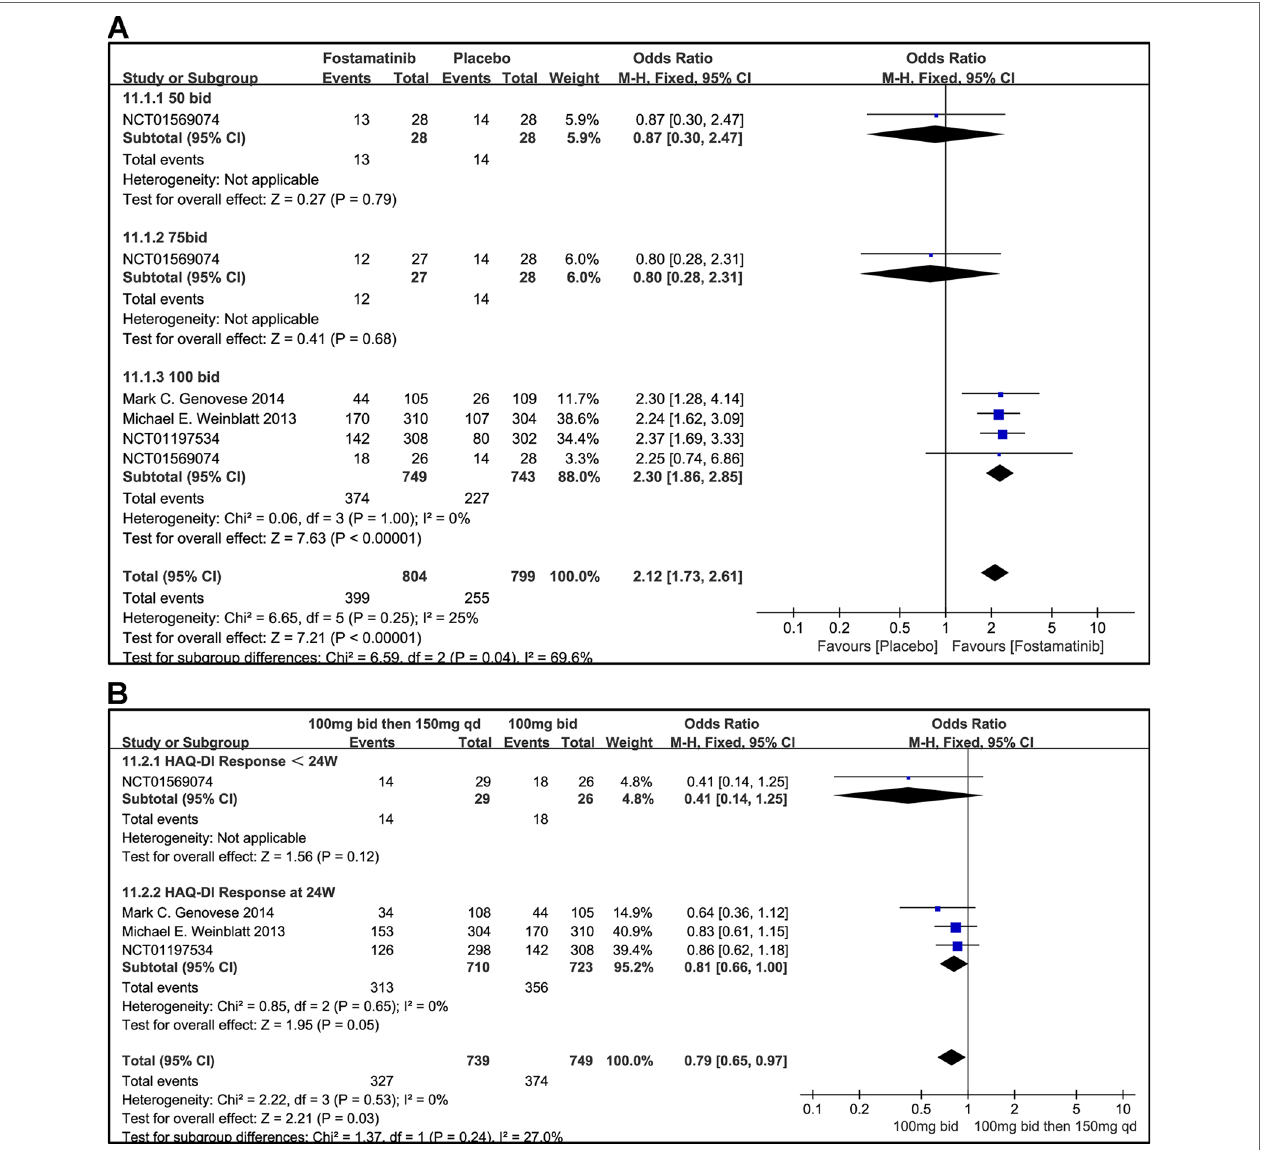
FIGURE 12 | Forest plots for the effect of multiple doses on HAQ-DI response at different time points. (A) Subgroups administered multiple doses (50, 75, and 100 mg bid) of fostamatinib vs. placebo at 24 weeks; (B) 100 mg bid for 4 weeks followed by 150 mg bid vs. 100 mg bid < 24 and 24